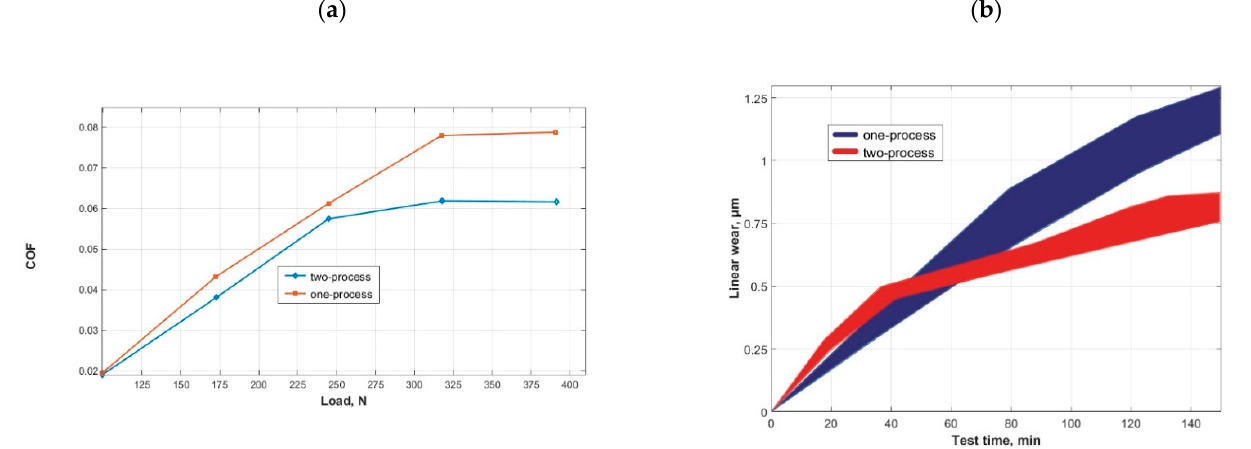
Figure 21. Friction coefficient as a function of load for a rotational speed of 4000 rpm ( a ), linear wear as a function of test duration ( b ), adapted from [190].